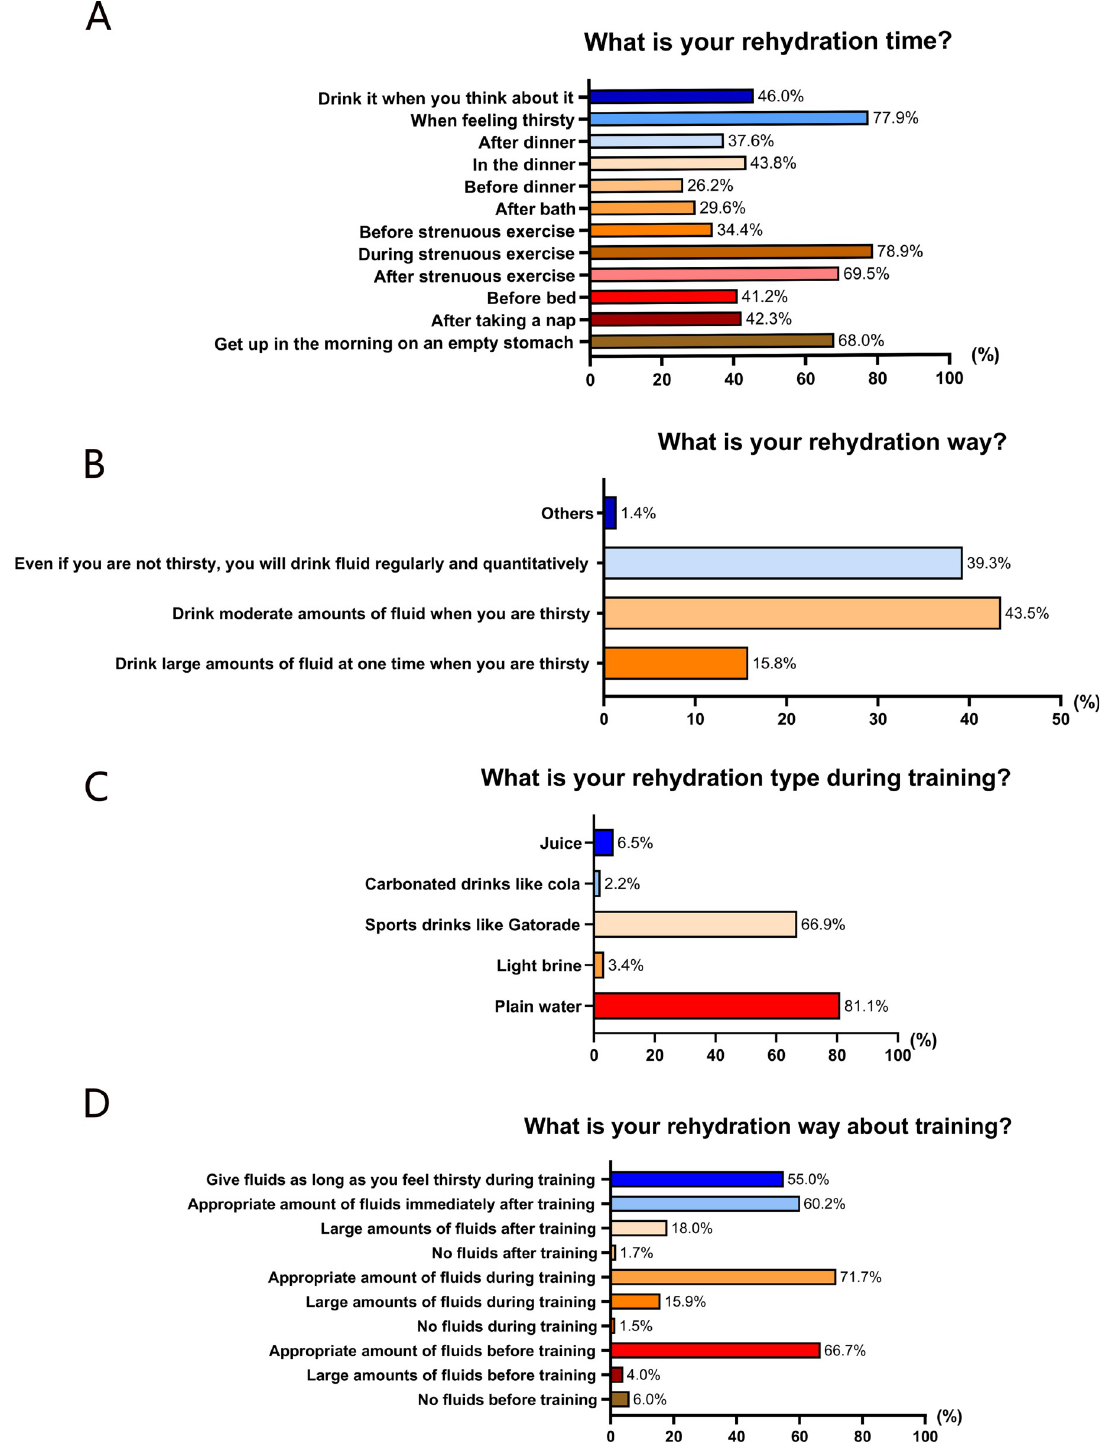
Fig 2. Practices of fluid replacement. (A) Rehydration time; (B)Rehydration way; (C) Rehydration type during training; (D) Rehydration time about training.